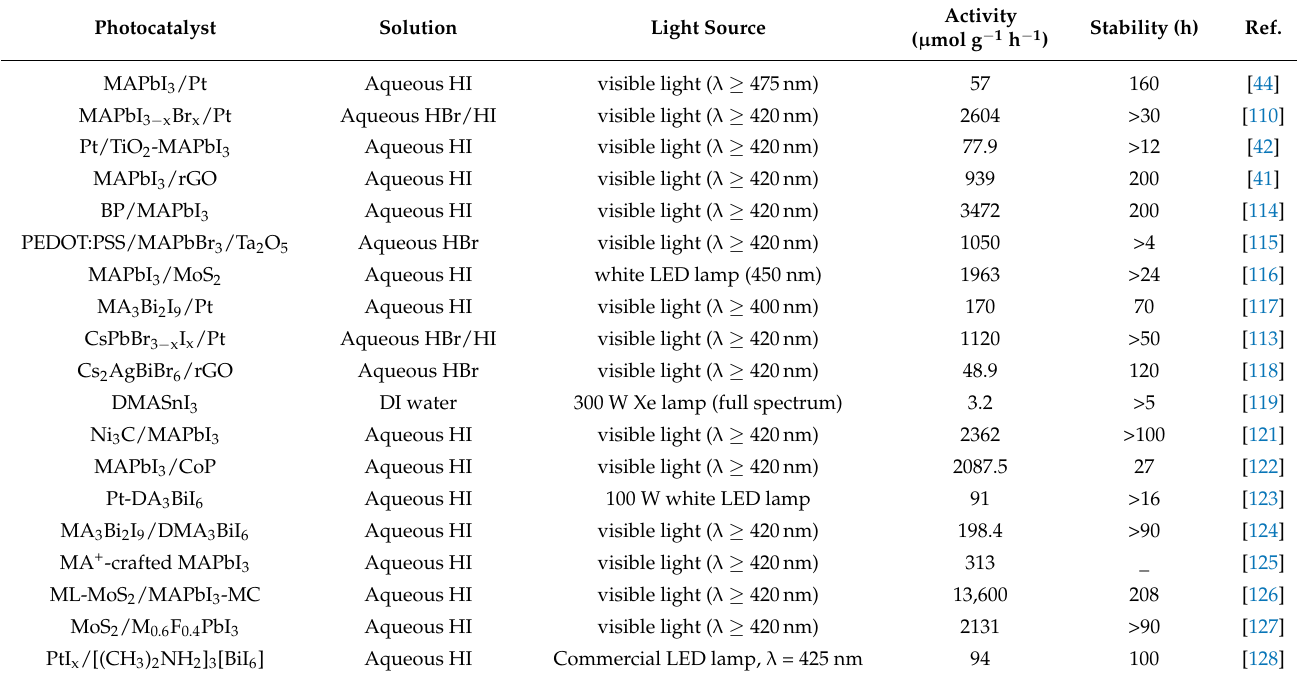
Table 1. Summary of photocatalytic hydrogen evolution activity of halide perovskite-based